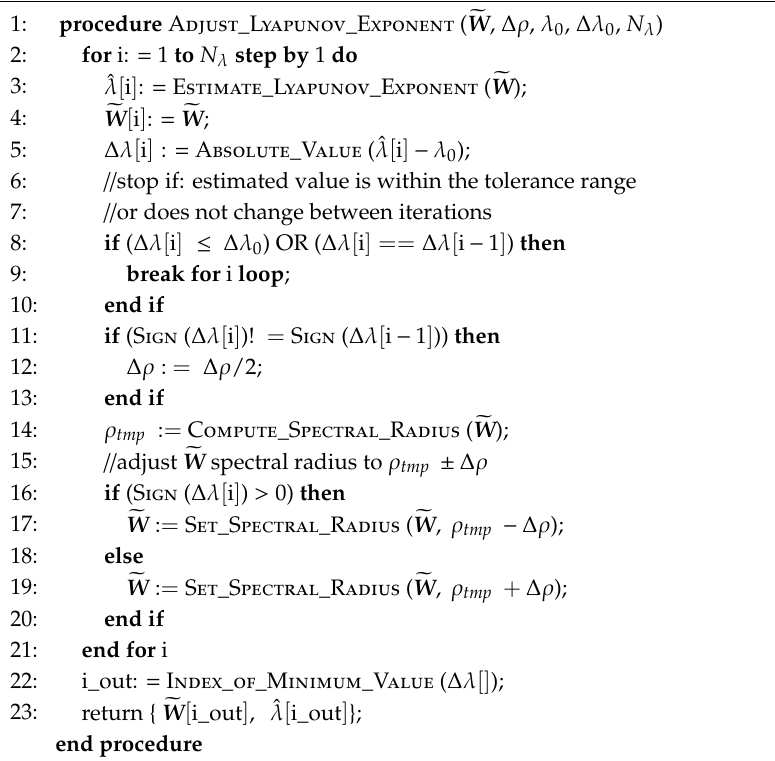
Algorithm 1. Lyapunov exponent adjustment